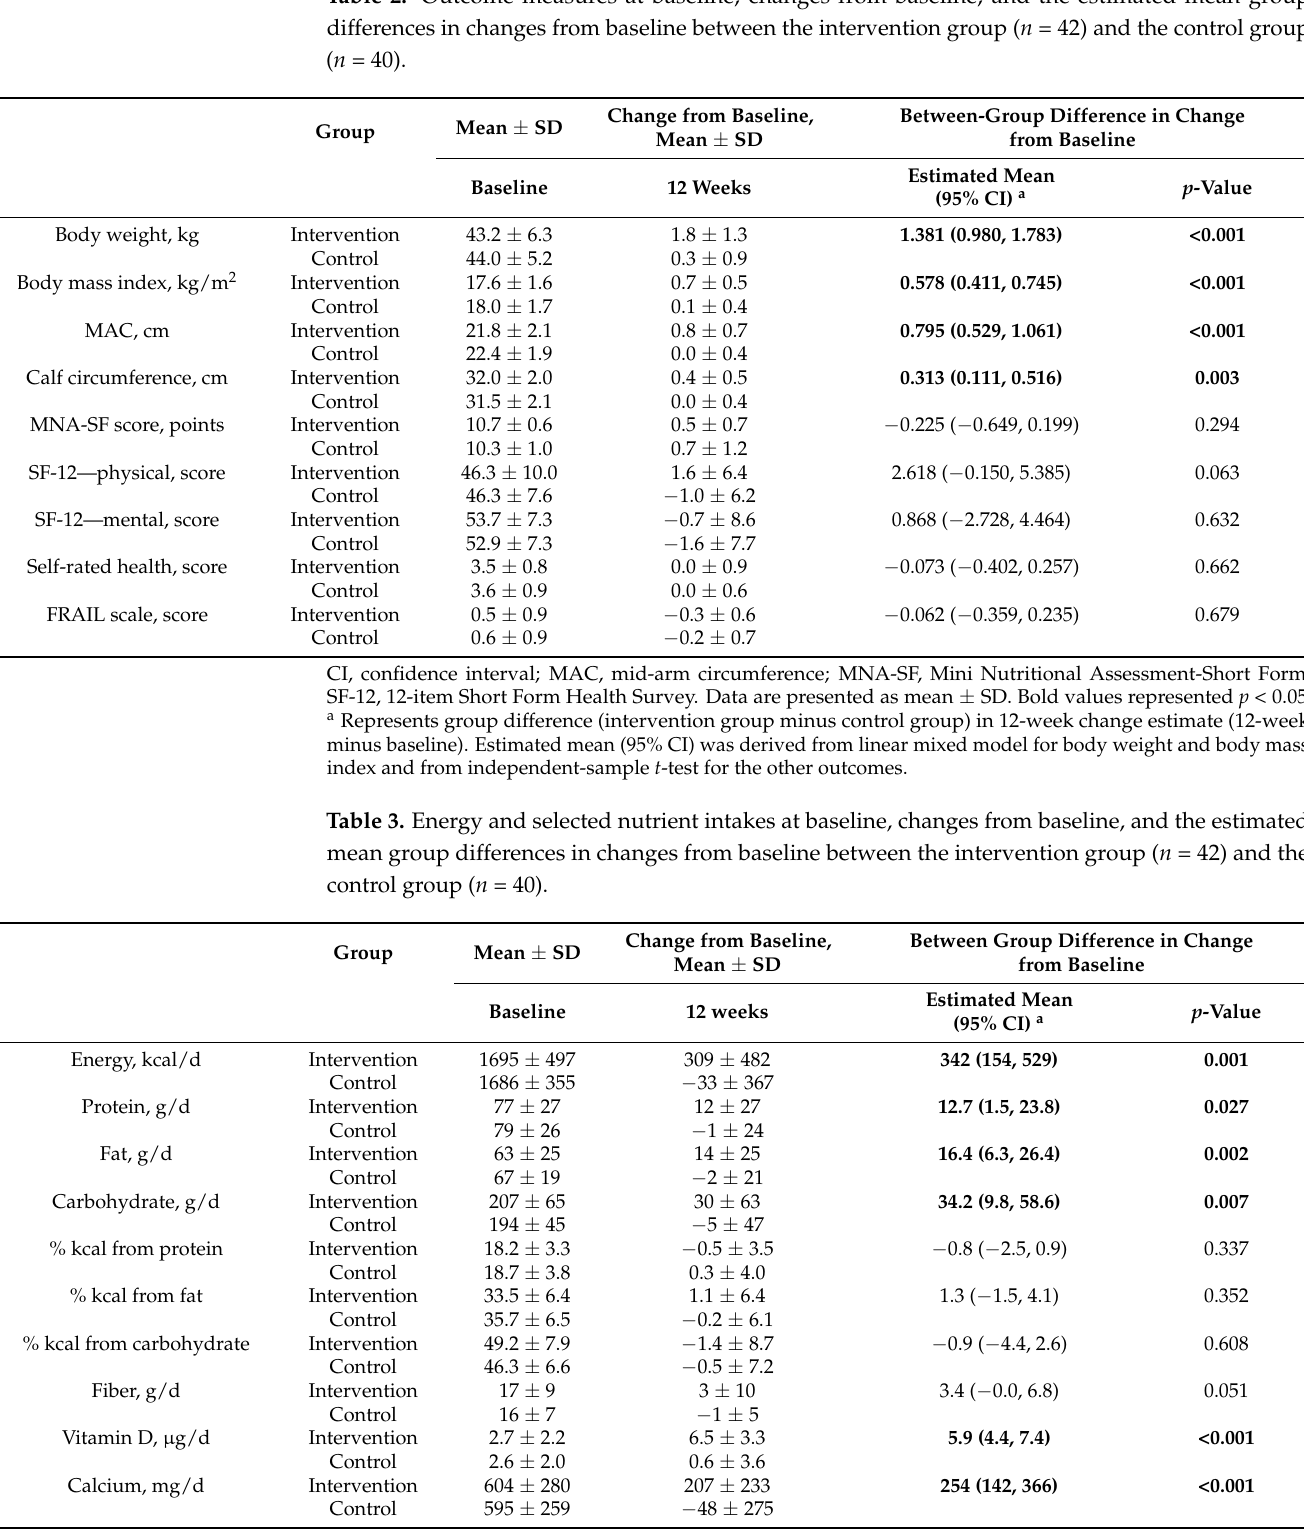
Table 2. Outcome measures at baseline, changes from baseline, and the estimated mean group differences in changes from baseline between the intervention group ( n = 42) and the control group ( n = 40). Change from Baseline, Between-Group Difference in Change Group Mean ± SD Mean ± SD from Baseline Estimated Mean p -Value Baseline 12 Weeks (95% CI) a